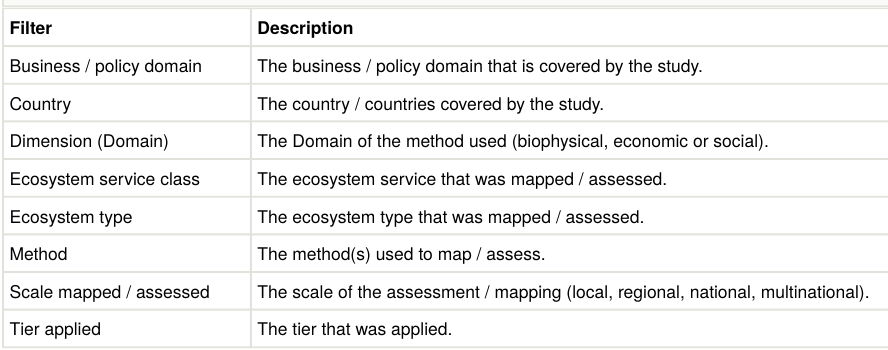
Search fi lters implemented by the